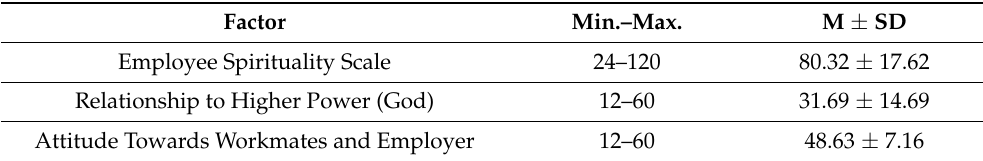
Table 2. Descriptive statistics ( N = 460).